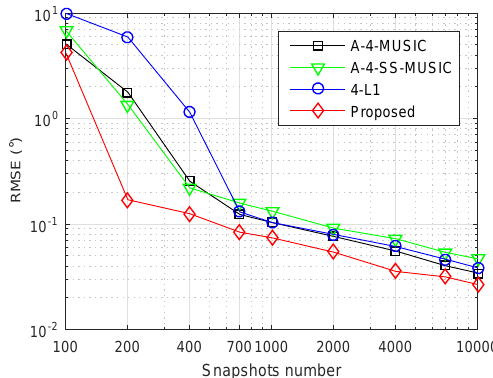
Figure 8. RMSE performance of four methods with non-circular sources, M = 5, K = 6, r = 0.1 ◦ , SNR = 6